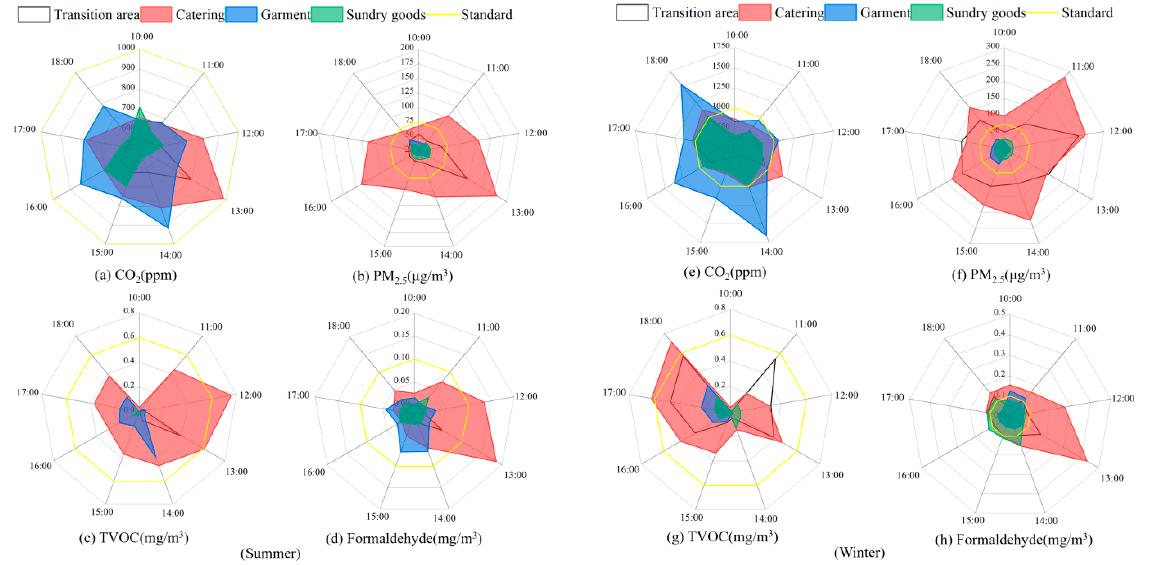
Figure 7. The indoor CO 2 ( a , e ), PM 2.5 ( b , f ), TVOC ( c , g ), and formaldehyde ( d , h ) levels at different times in